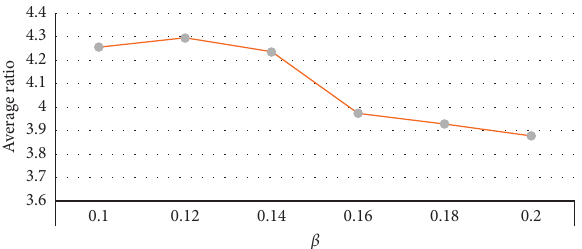
Figure 10: The trend of the average ratio as β